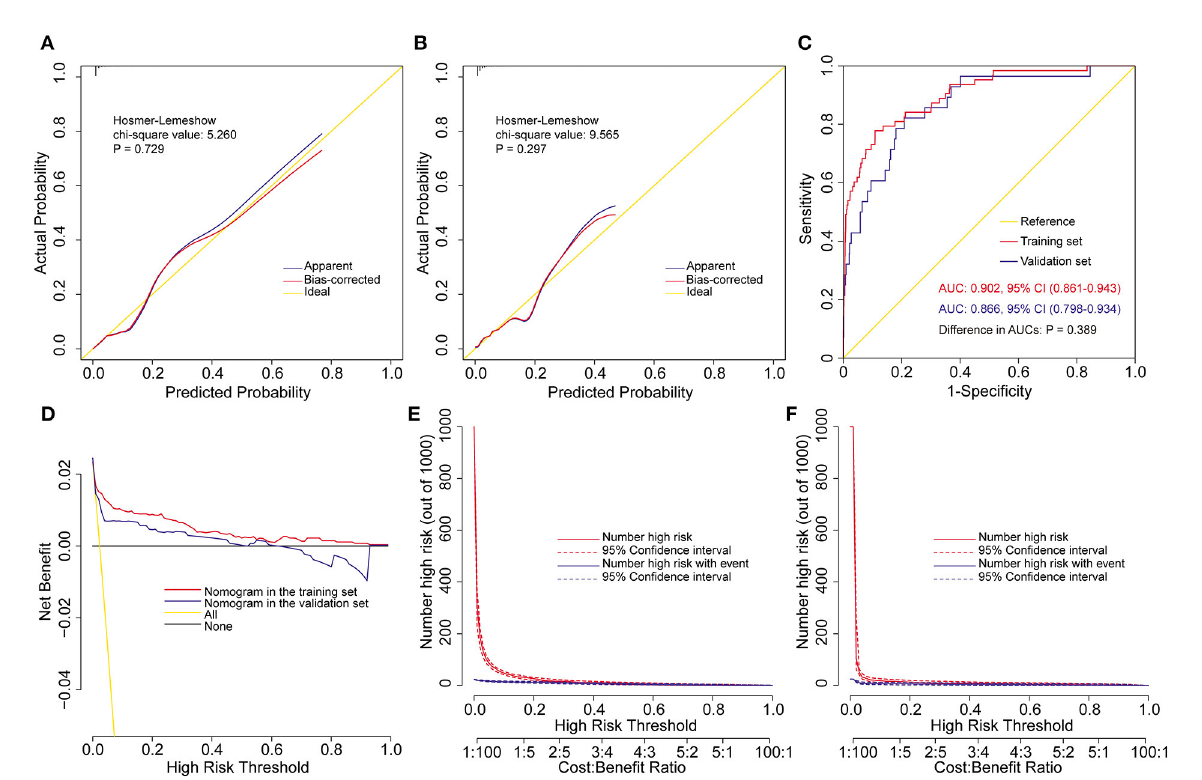
FIGURE2 Assessment of the prediction model for severe hypoxemia after heart valve surgery. Calibration plots and goodness-of-fit test in the training set (A) and the validation set (B) , ROC curves and the AUC in the training and validation sets (C) , decision curves in the training and validation sets (D) , and clinical impact curves in the training set (E) and the validation set (F) . AUC, area under the receiver operating characteristic curve; CI, confidence interval; ROC, receiver operating characteristic curve.